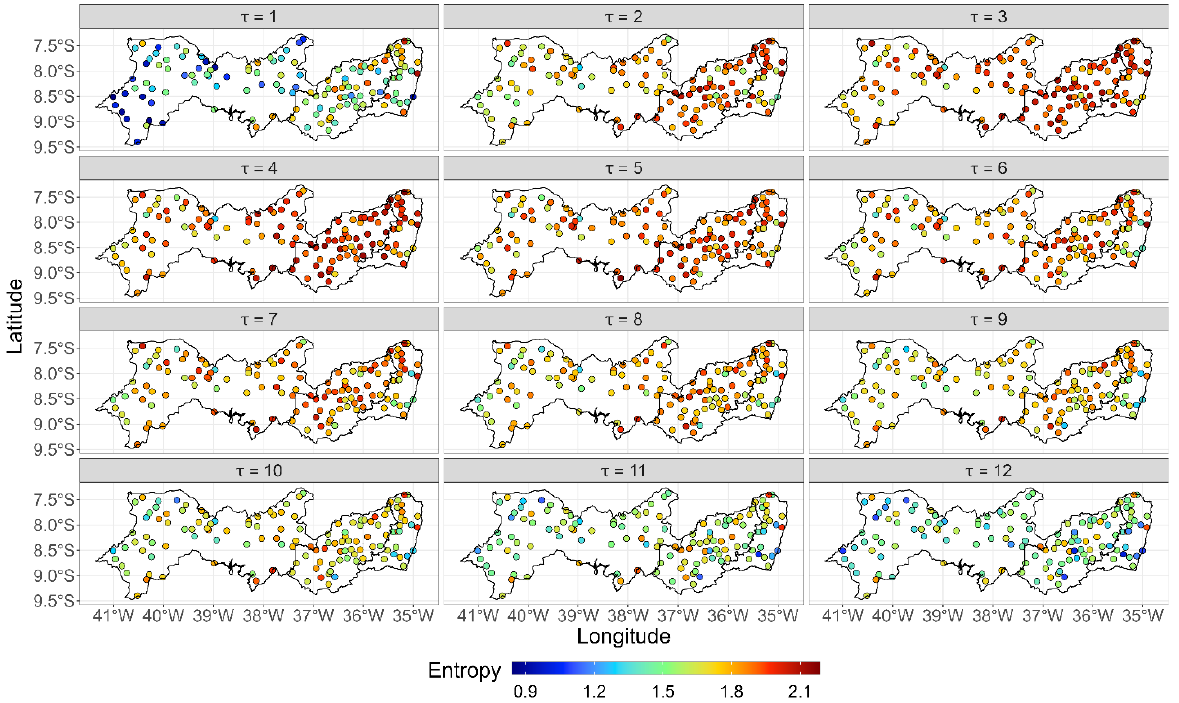
Figure 6. Spatial distribution of MMSE ( τ = 1, 2, …, 12 months) over the state of Pernambuco for rainfall anomalies series.